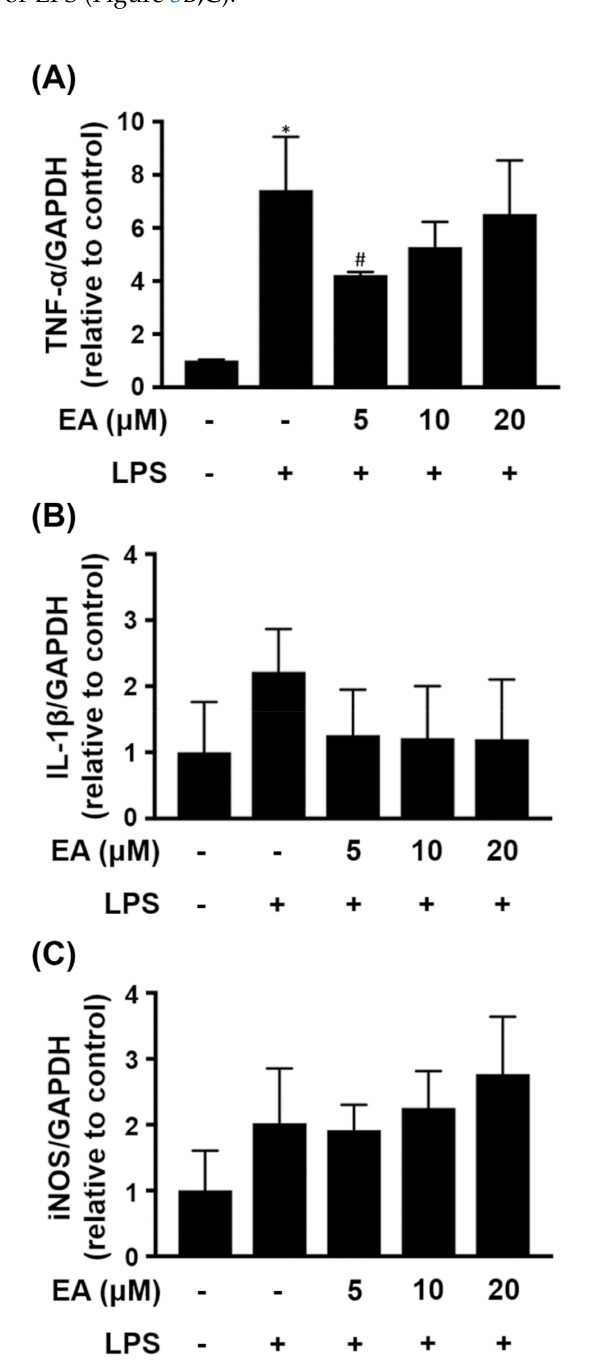
Figure 3. Effect of EA on proinflammatory mediators in LPS-treated CTX TNA2 cells. CTX TNA2 cells were treated with the indicated concentration of EA for 15 min and then stimulated with LPS (250 ng/mL) for 24 h. The transcriptional levels of ( A ) TNF- α , ( B ) IL-1 β and ( C ) iNOS in the cells were detected by qRT-PCR ( n = 3). The data are expressed as fold changes relative to the control rats. The results are expressed as the mean ± SD. * p < 0.05 compared to the control group, # p < 0.05 compared to the LPS